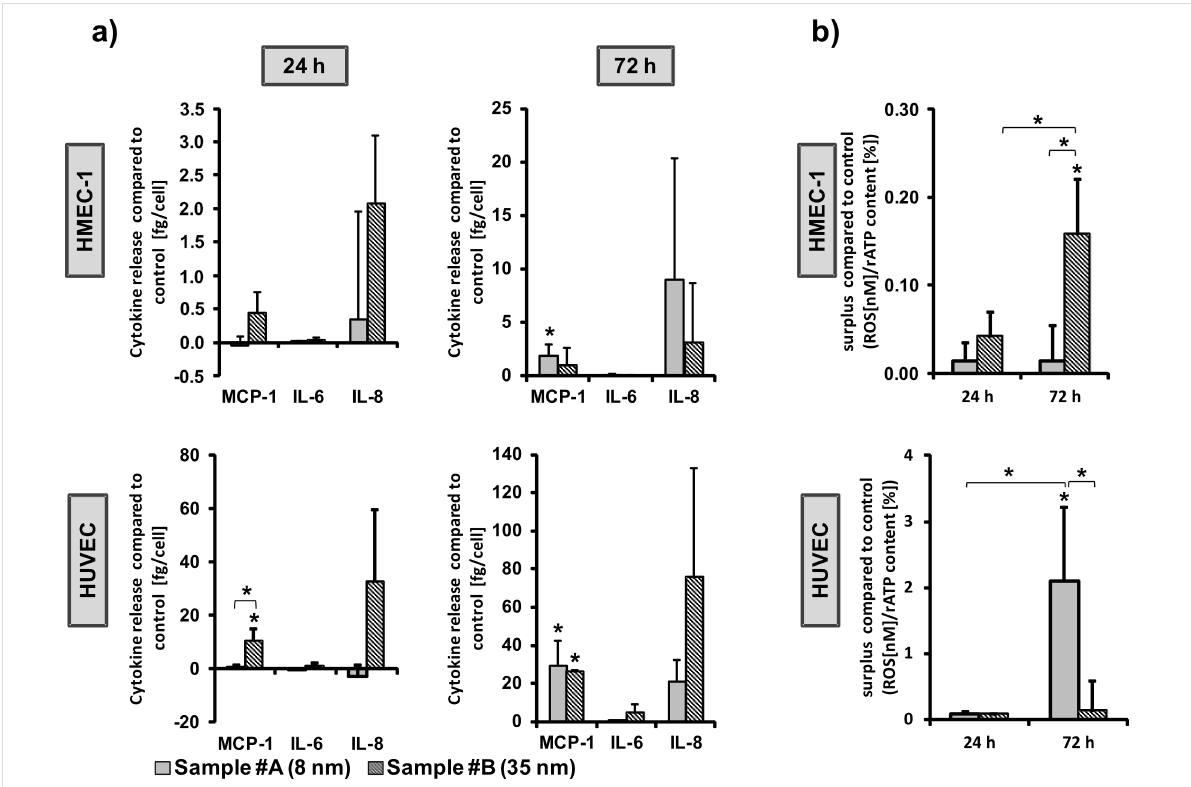
Figure 4: Pro-inflammatory impact and ROS generation of CeO 2 nanoparticle exposure on endothelial cells. a) MCP-1, IL-6 and IL-8 release after nanoparticle treatment (100 µg/mL) at different nanoparticle exposure times (24 h; 72 h) are shown for HMEC-1 and HUVEC; data depicted as the difference between values after treatment and untreated controls (surplus compared to control). Values of the positive controls for the pro-inflamma- tory effects and the absolute values of the untreated control cells are found in the Supporting Information File 1 (Figure S2 and Figure S3, respective- ly). b) Intracellular ROS production after CeO 2 nanoparticle treatment, data depicted as the difference between values of treated and untreated control cells (surplus compared to control). ROS = reactive oxygen species; n = 3 independent experiments; *single asterisks over the bar indicate significant differences (P ≤ 0.05) between the appropriate treatment and untreated control cells; *asterisks, which are together with a parenthesis, indicate signifi- cant differences (P ≤ 0.05) between different nanoparticle formulations or between different time